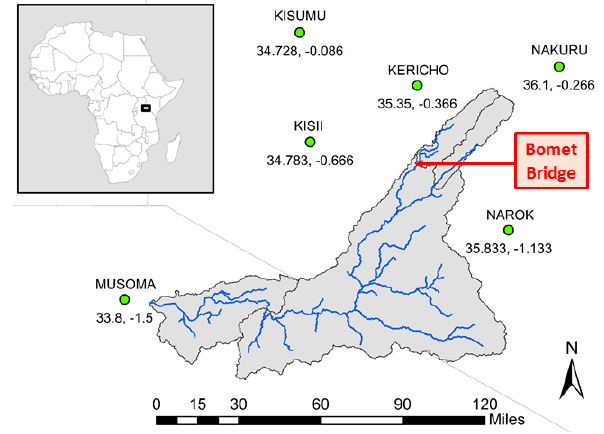
Figure 1. The Mara River basin and the Nyangores River sub-basin (Roy et al., 2017a). The discharge station is located at Bomet Bridge (red dot). Meteorological stations (green dots) are located in the surrounding regions.